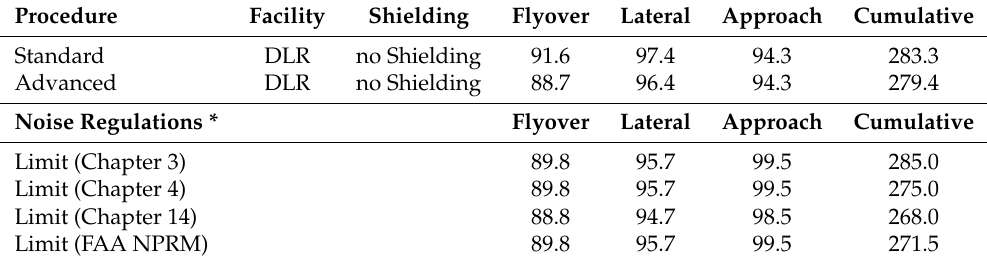
Figure 8. Calculated PNLT of the aircraft TWO over time for approach reference noise measurement point. 10 dB-down time is filled grey and PNLTM is marked. 10 dB-down time represents the relevant time of the PNLT course for the calculation of the EPNL. Table 4. Simulated certification levels at individual measurement points (flyover, lateral and ap- proach) and cumulative level for aircraft TWO. Limits of individual measurement points and cumu- lative from ICAO Annex 16 and FAA NPRM for Noise Certification of Supersonic